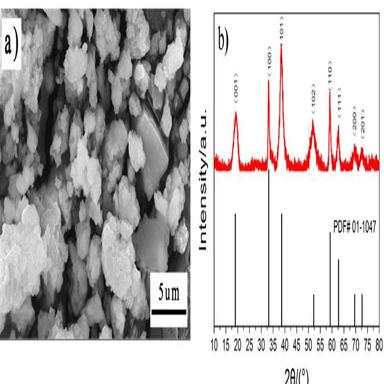
SEM image (a) and XRD pattern (b) of the precursor.